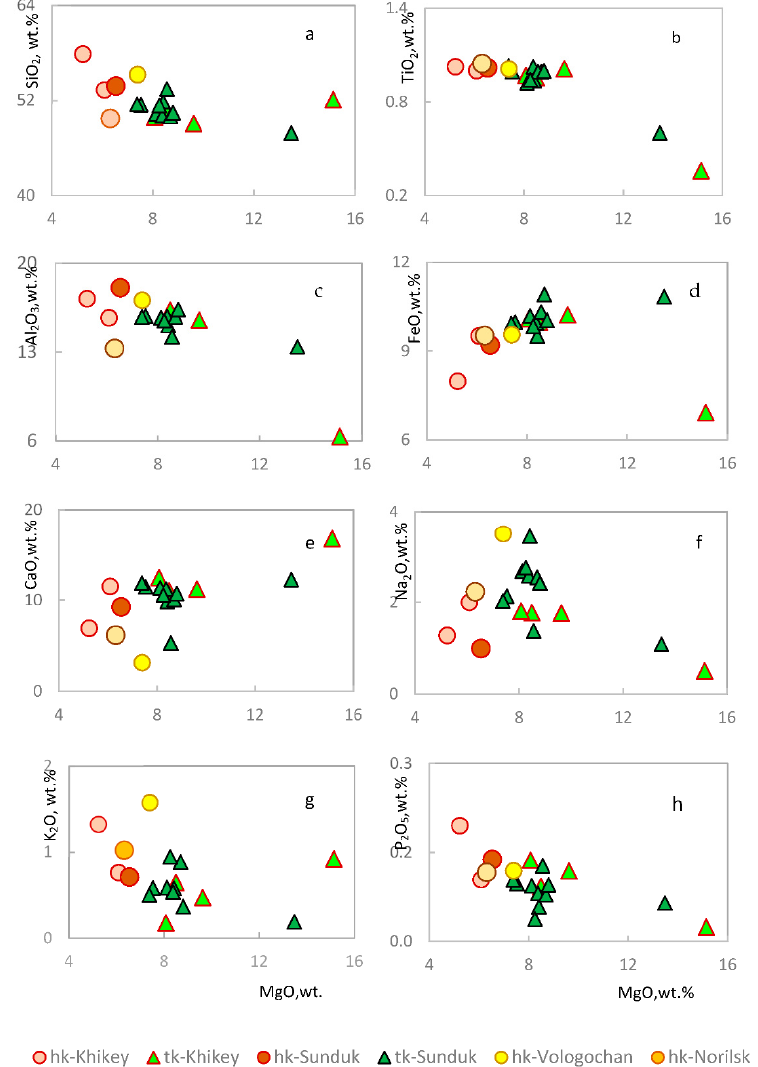
Figure 11. Diagrams MgO vs. SiO 2 ( a ), TiO 2 ( b ), Al 2 O 3 ( c ), FeO ( d ), CaO ( e ), Na 2 O ( f ), K 2 O ( g ), and P 2 O 5 ( h ) for the rocks of the Khakanchansky and Tuklonsky Formations.